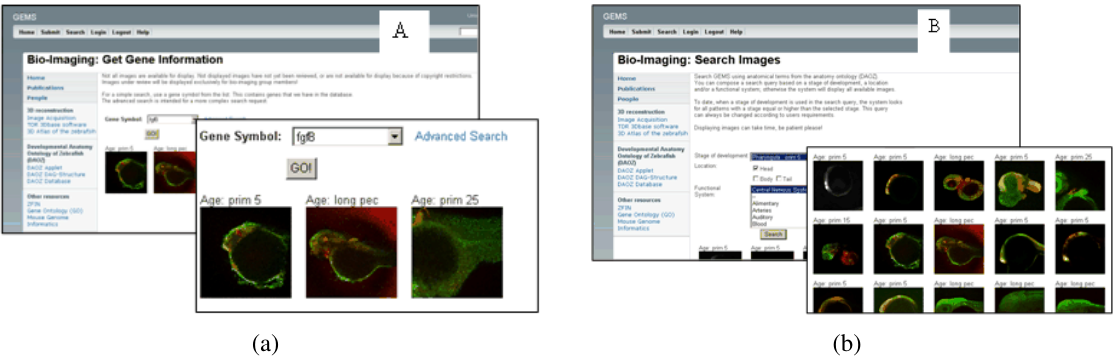
Figure 4: Search results from: (a) Search option using gene symbol. (b) Search option using concepts from DAOZ.